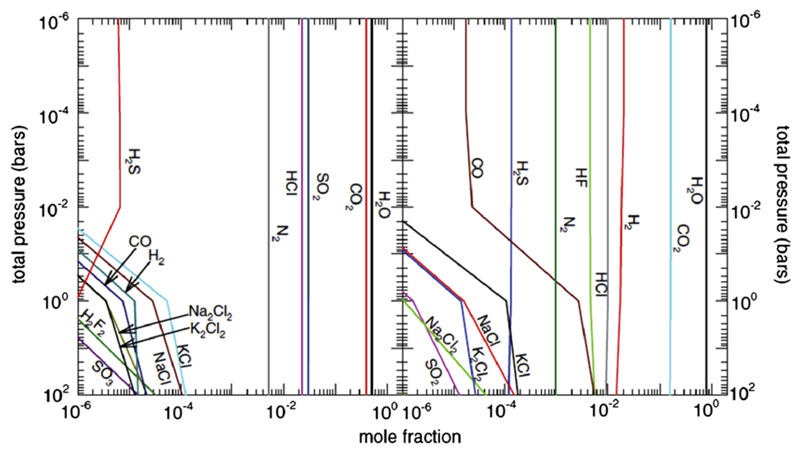
Equilibrium atmospheric composition for a GJ 1214b-like exoplanet, assuming the atmosphere results from outgassing from a high-temperature felsic silicate terrestrial crustal composition (left) or a more mafic bulk-Earth silicate composition (right). Figure from Schaefer et al. (2012)